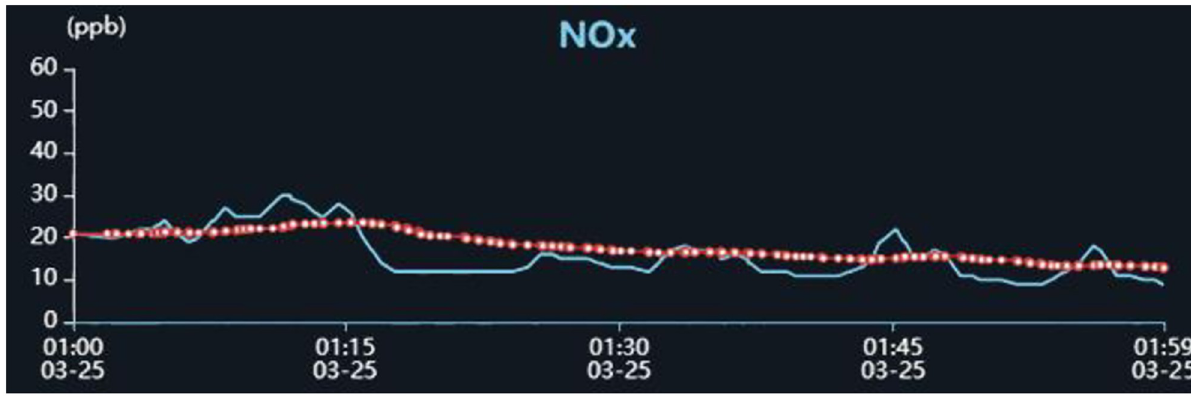
Fig 6. NO x signal with drift